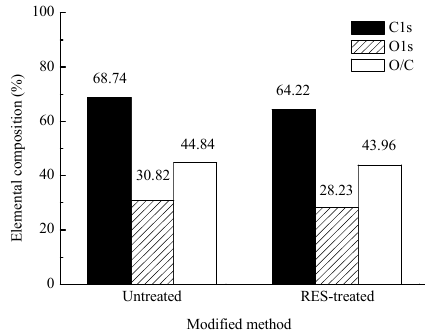
Figure 9. Surface elementary composition of untreated and RES-treated BF.